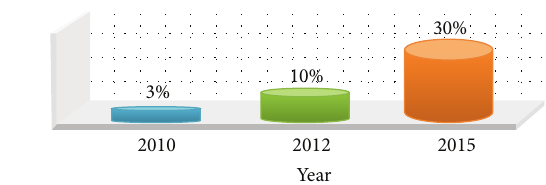
Figure 1: Wireless Internet usage.